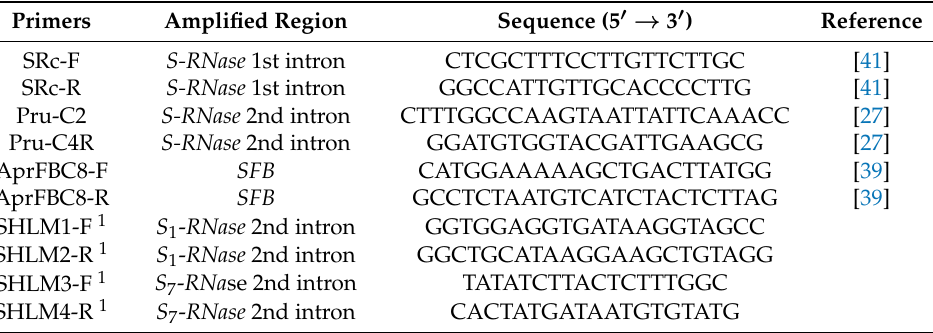
Table 2. Primers used in this study for the identification of S -alleles in Prunus armeniaca .